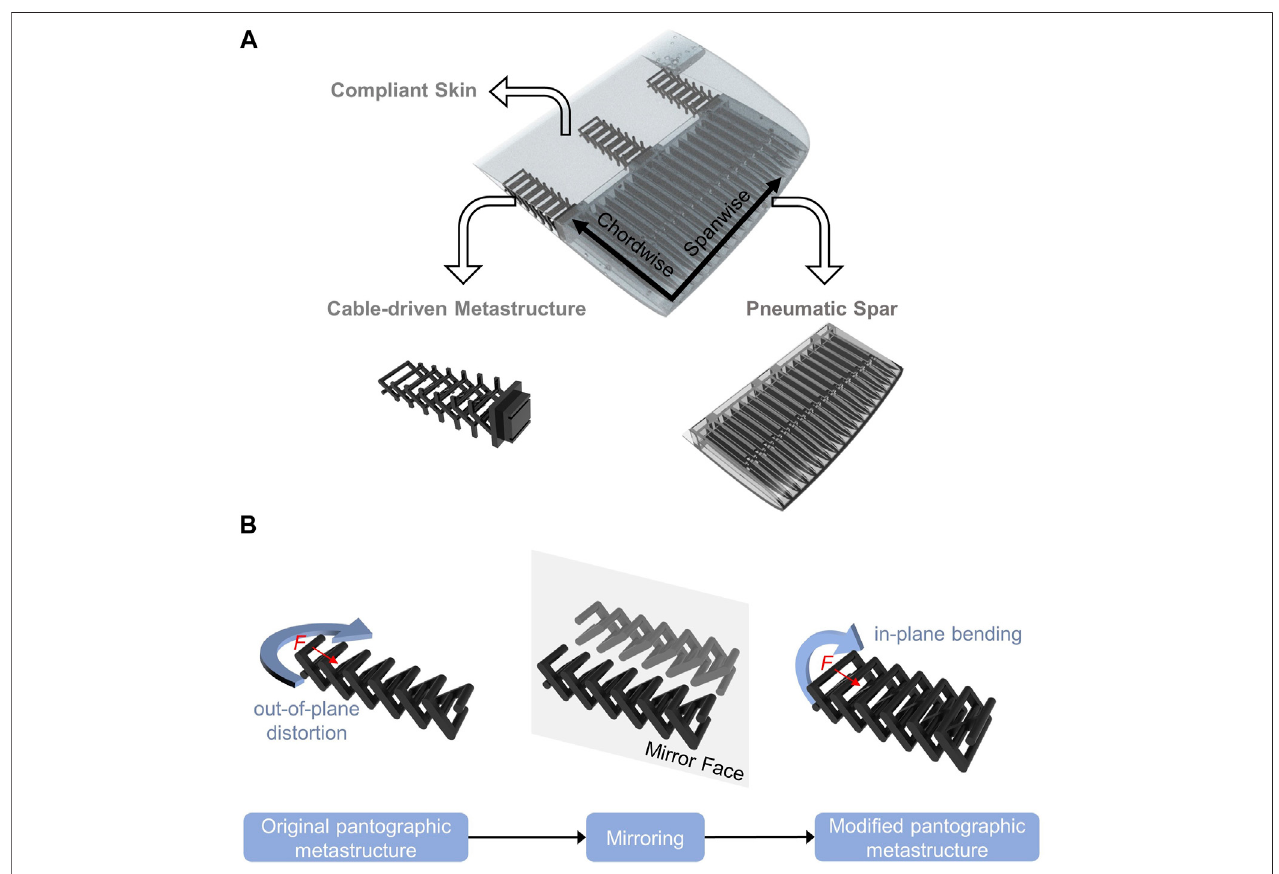
FIGURE 1 | (A) Rendering of morphing wing composed of bidirectional SPAs and modi fi ed pantographic metastructure; (B) Original pantographic metastructure and modi fi ed one.